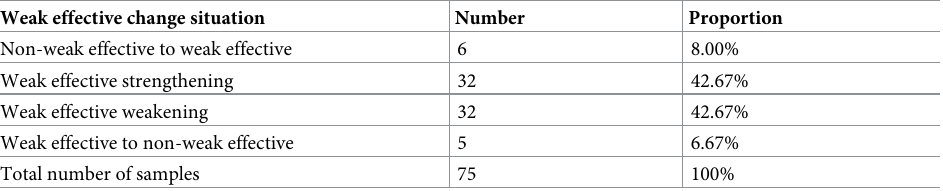
Table 3. Statistics of macro-policy information and weak market efficiency